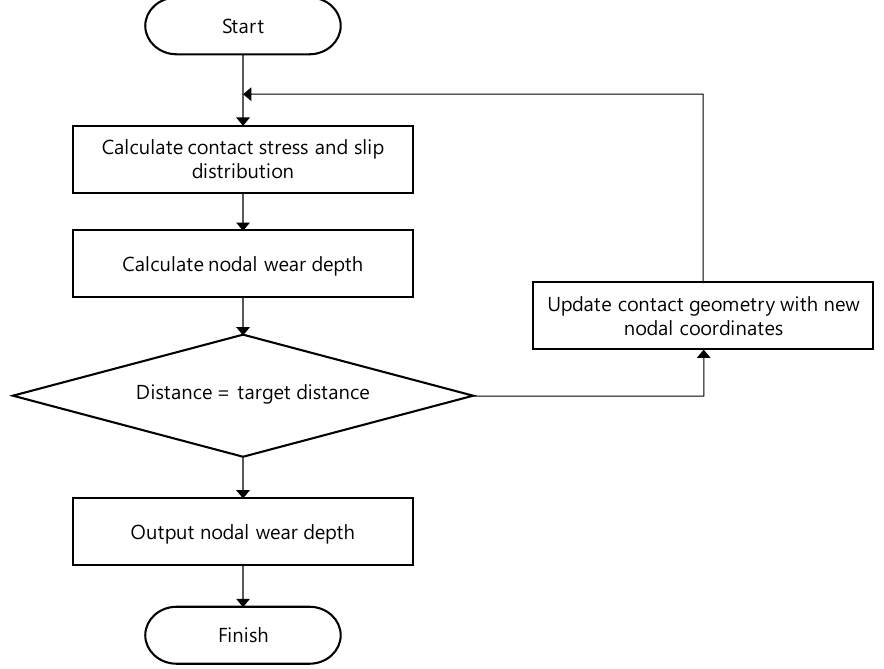
Figure 12. Flow chart for conventional wear simulation using the McColl’s approach [85].